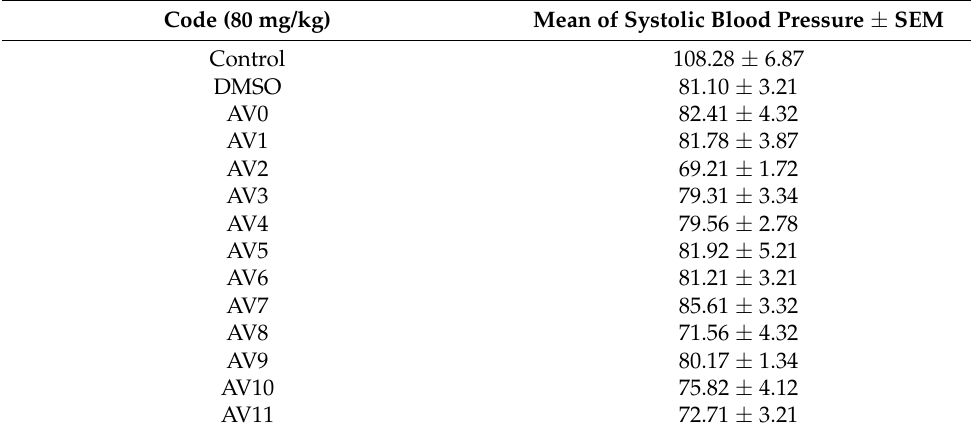
Table 4. Results of antihypertensive effects of synthesized derivatives of 2-(N-((2 (cid:48) -(2H-tetrazole-5-yl)-